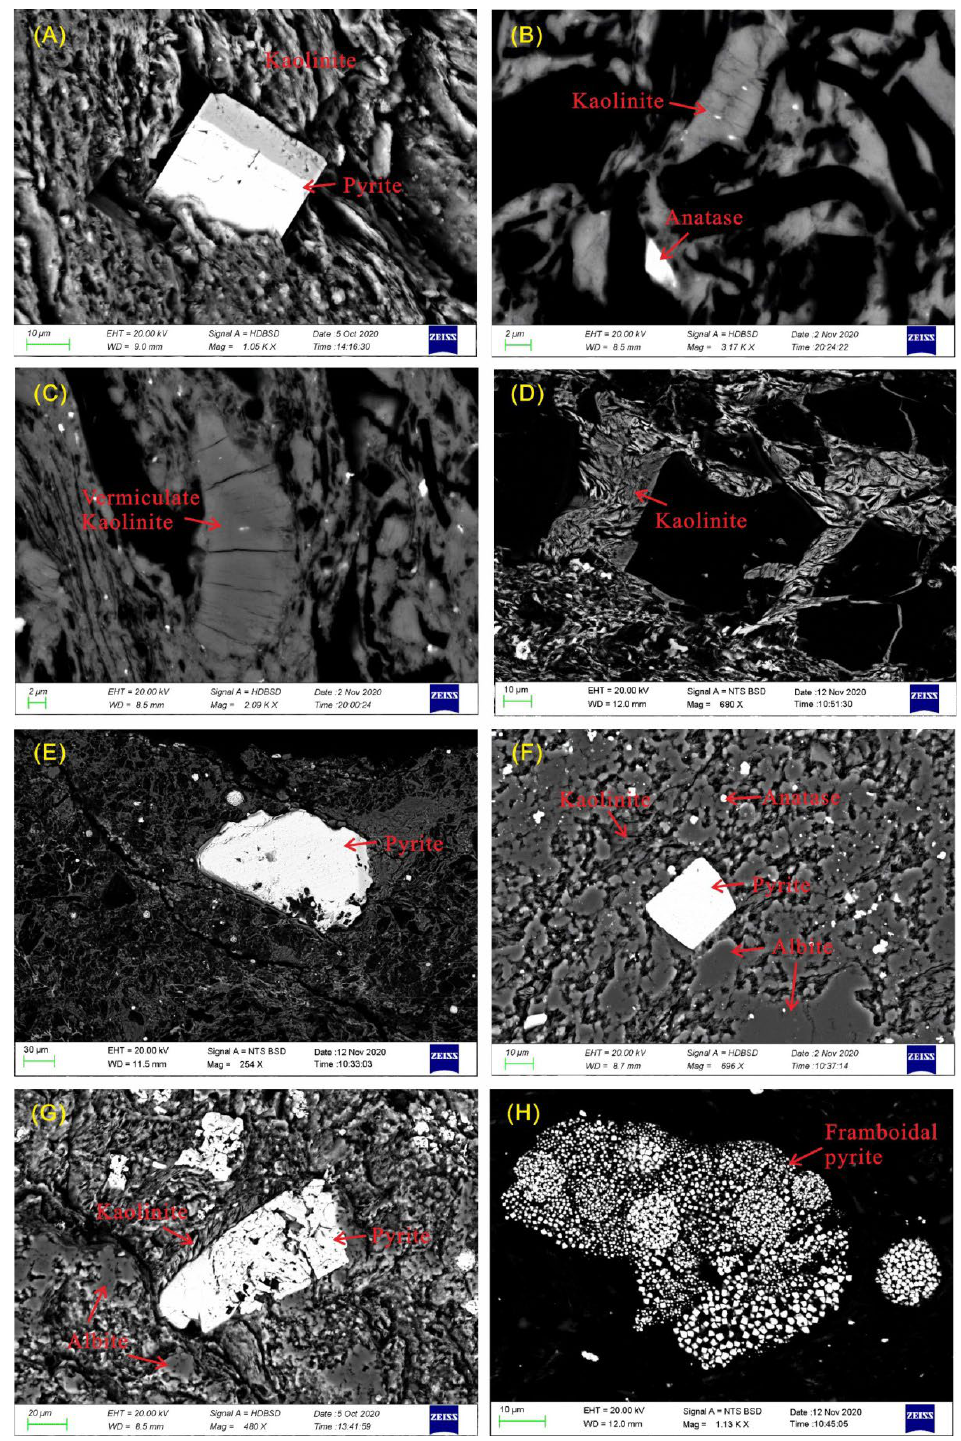
Figure 6. Scanning electron microscope (SEM) back-scattered electron images of minerals ( A – H ): ( A ) euhedral pyrite embedded within kaolinite matrix (sample SL-9); ( B ) kaolinite and anatase (sample SL-9); ( C ) vermiculate kaolinite (sample SL-12); ( D ) fracture-filling kaolinite (sample SL-5); ( E ) massive pyrite (sample SL-5); ( F ) albite, kaolinite, pyrite, and finely-grained disseminated anatase particles (sample SL-5); ( G ) kaolinite, albite, and pyrite (sample SL-5); and ( H ) framboidal pyrite aggregates (sample SL-16).